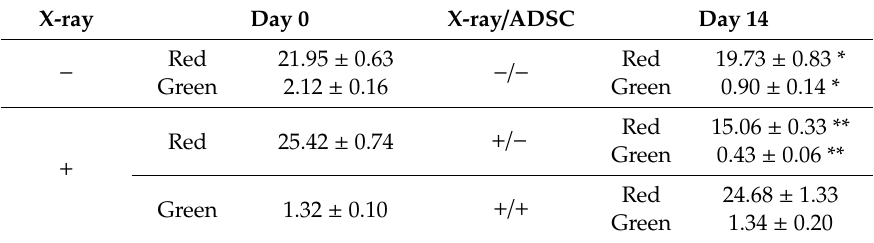
Red and green channel ratio was calculated following the formula ( n = 3–6): [(area of red or green channel) / (area of whole specimen)]. Each channel area was measured using ImageJ software setting as described in “Evaluation of fibrosis using picrosirius red staining”. The area of the whole specimen was measured using default values of the color threshold automatically set by ImageJ. * p < 0.05, ** p < 0.01 significantly di ff erent from day